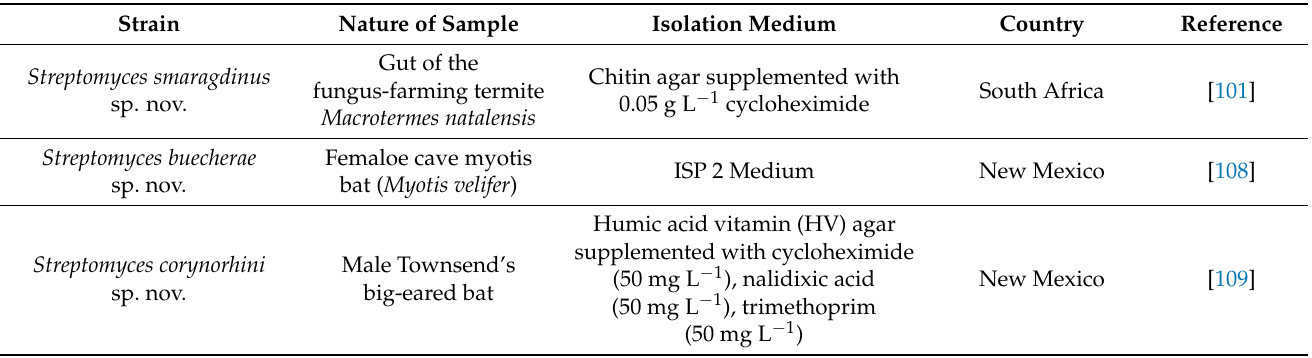
Table 3. Novel Streptomyces spp. reported from insects and other animals between 2015 and